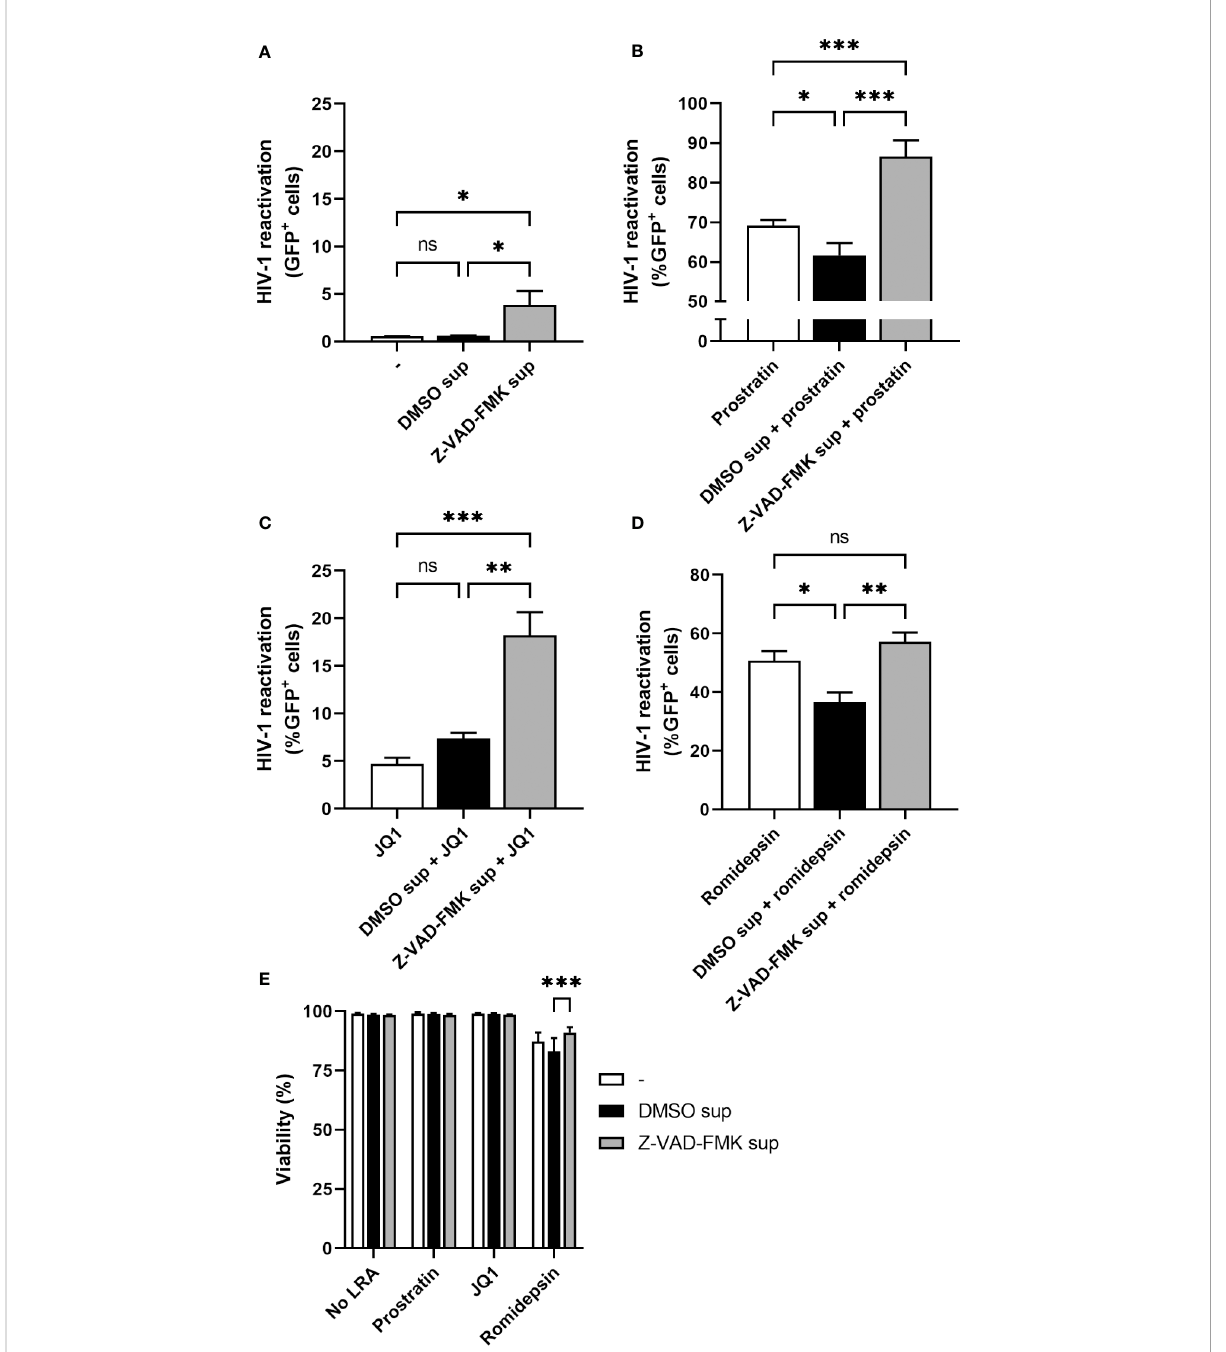
FIGURE 2 Supernatants of pan-caspase inhibitor-treated NK cells work in synergy with other LRAs. KHYG-1 cells were incubated with Z-VAD-FMK or only DMSO. After 24 h, supernatants were collected. Then, J-Lat cells were cultured in normal media or in the collected supernatants without any additional LRAs (A) , or with added prostratin (2 µM) (B) , JQ1 (1 µM) (C) , or romidepsin (17.5 nM) (D) for 22 h. HIV-1 reactivations as measured by GFP-positivity was assessed by fl ow cytometry. (E) Cell viability of J-Lat cells was assessed by near infrared viability dye staining and fl ow cytometry. Data points are plotted as mean ± SD from three individual experiments. (ns, non-signi fi cant; *p < 0.05, **p < 0.01, ***p < 0.001;